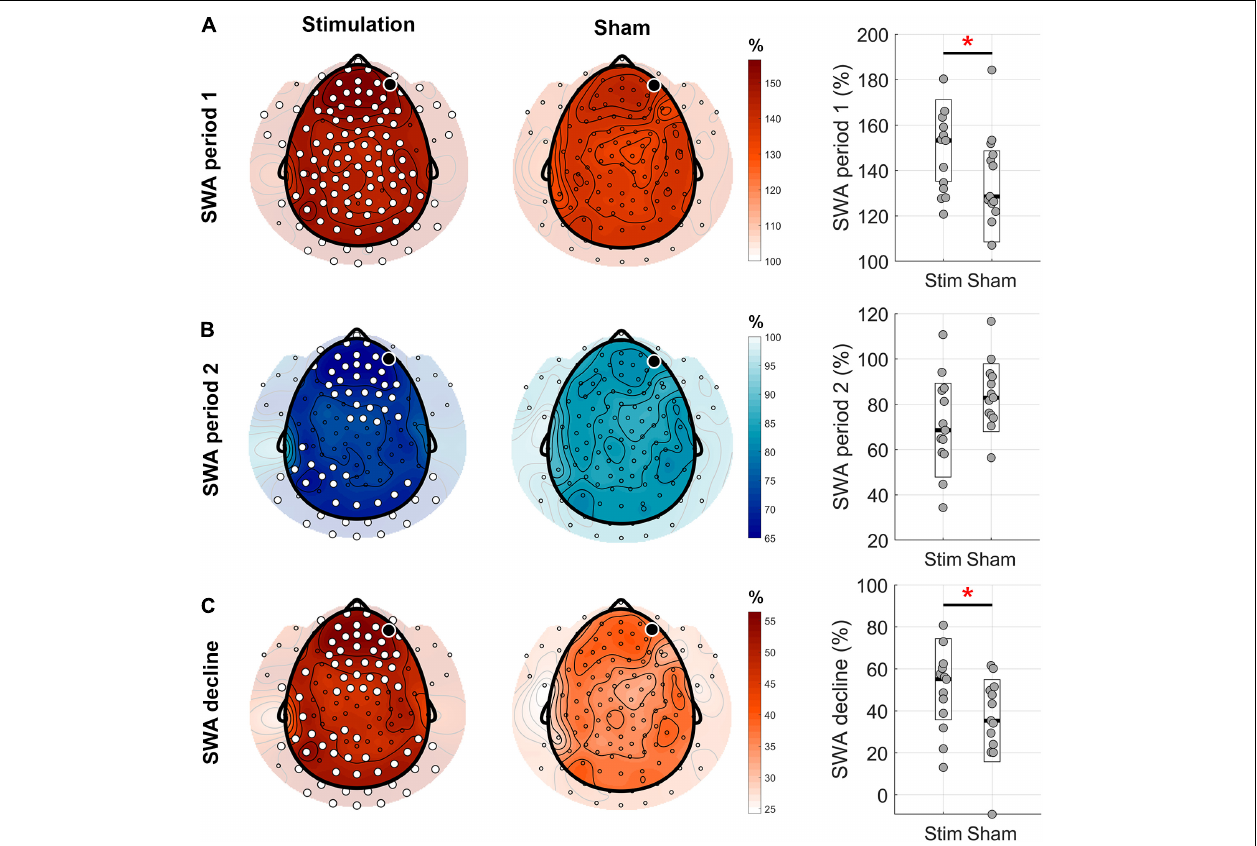
FIGURE 4 | Topographical distribution of the homeostatic response to the phase-targeted auditory stimulation. (A) Mean slow-wave activity (SWA) in the first 2.5 h period from sleep onset (period 1) normalized by mean SWA during the entire night in the stimulation and sham conditions (white dots indicate significant changes between the two conditions, cluster corrected paired two-sided t -test, N = 13, p clust = 0.004, d = 0.97). Boxplots (right hand column) show a comparison of normalized values averaged across all channels for stim and sham conditions ( t 12 = 3.26, p = 0.007, red asterisk indicates significant change). (B) Mean SWA in the following 2.5 h period (period 2) normalized by mean SWA during the entire night, in stimulation and no stimulation conditions (cluster corrected paired two-sided t -test, N = 13, p clust < 0.024, d < –0.51). On average, across all channels, there was a trend toward lower SWA in sham versus stim ( t 12 = –2.12, p = 0.055). (C) SWA decline in percent from the first 2.5 h to the following 2.5 h of sleep showed a rather global, stronger decline in the stimulation compared to the sham condition (cluster corrected paired two-sided t -test, N = 13, p clust < 0.023, d > 0.51). On average across all channels, the SWA decline was higher in stim compared to sham condition ( t 12 = 2.37, p = 0.035, red asterisk indicates significance). The black dots indicate the target channel Fp2.